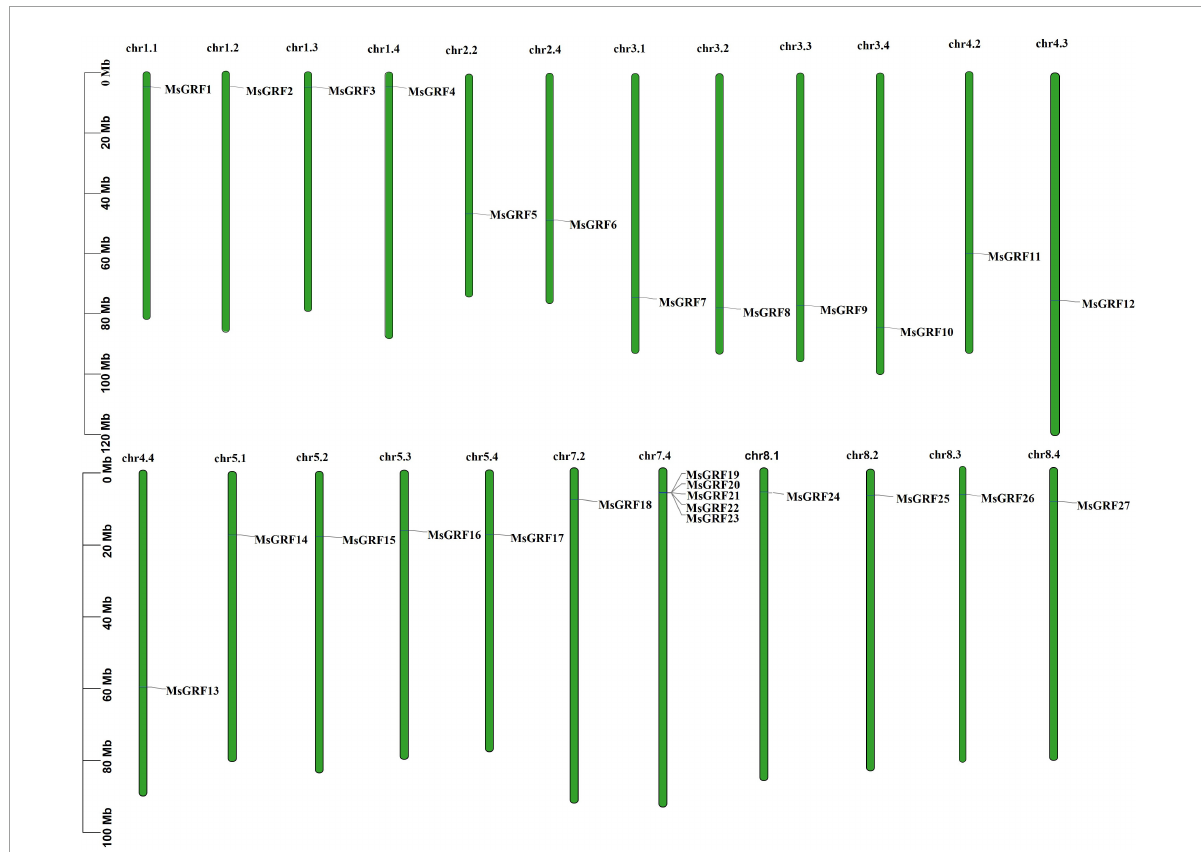
FIGURE3 The distribution of MsGRFs on alfalfa chromosomes. The green bars represent each chromosome, and the black lines label the position of each MsGRF